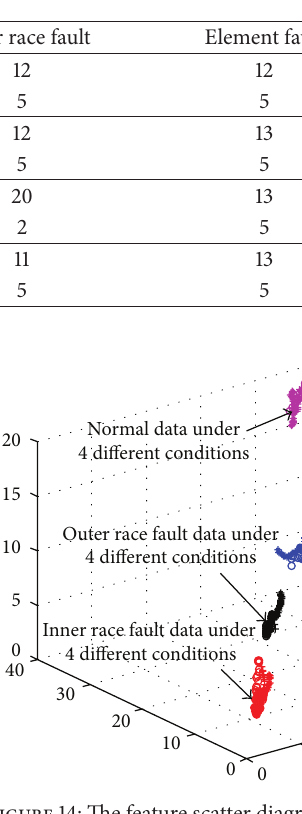
Figure 14: The feature scatter diagram in the 3-dimensional space.